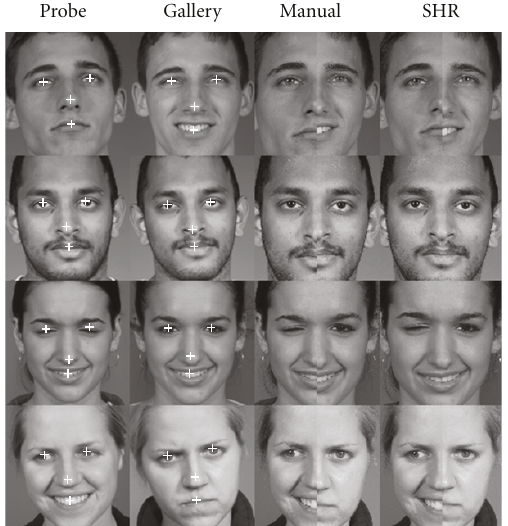
Figure 9: Examples of registration, the first and second column contain the face detection regions of probe and gallery images together with the manual landmarks. The third column, we present half of the probe image and other half of gallery image to compare the final alignment of manual registration. For the fourth column, we performed the same procedure as in the third column but with user-independent SHR.